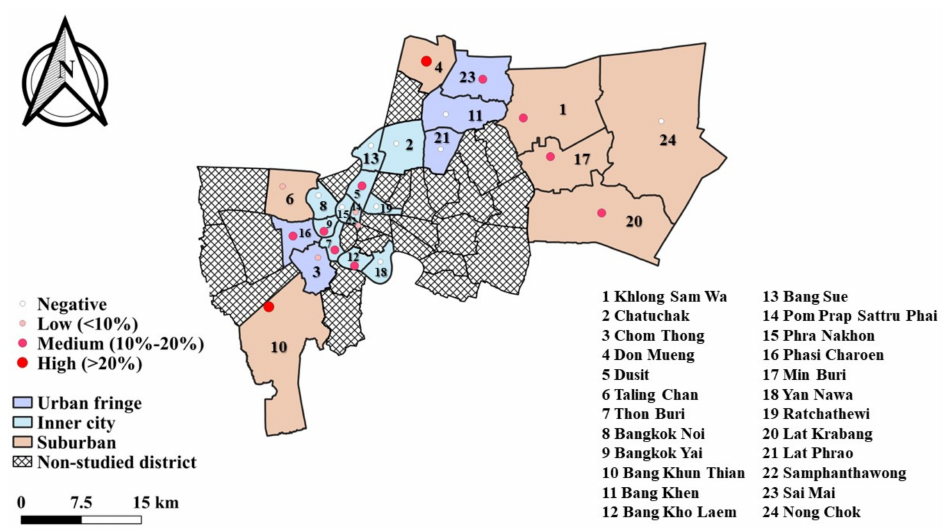
Figure 1. The map of Bangkok showed the geographical characteristic of the study areas into three zones and distribution of hookworm infections in semi-domesticated cats in Bangkok, Thailand.